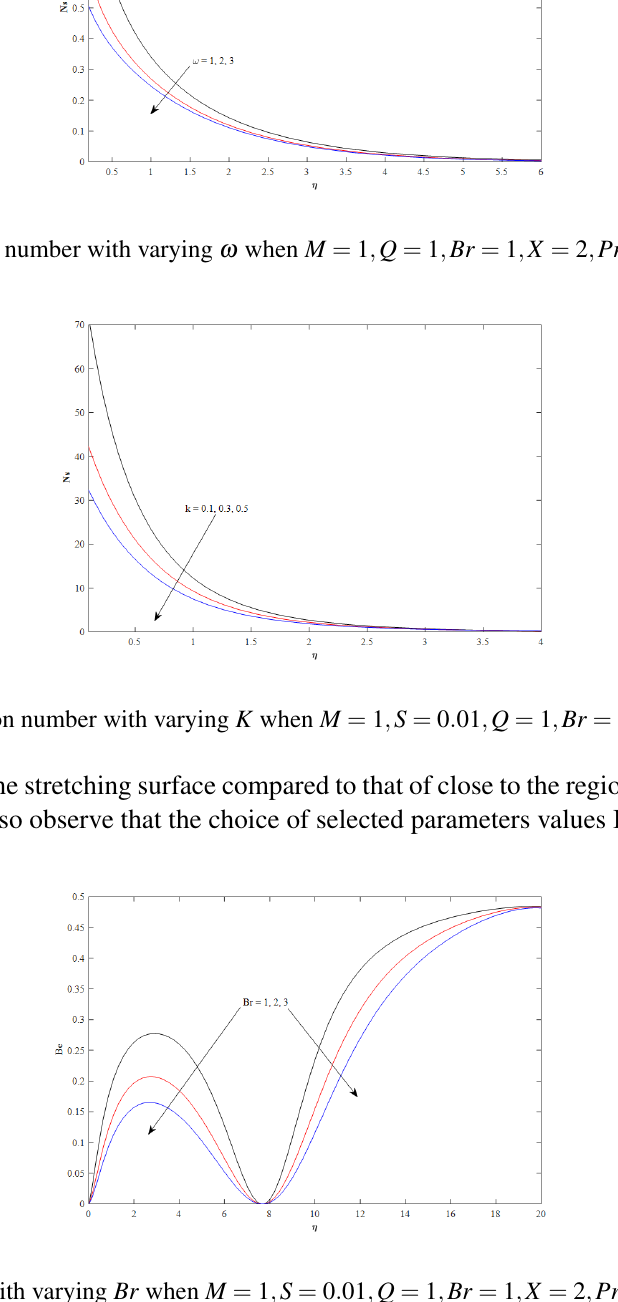
Fig. 7 Bejan number with varying Br when M = 1 , S = 0 . 01 , Q = 1 , Br = 1 , X = 2 , Pr = 2 , ω = 1 , K = 0 . 95